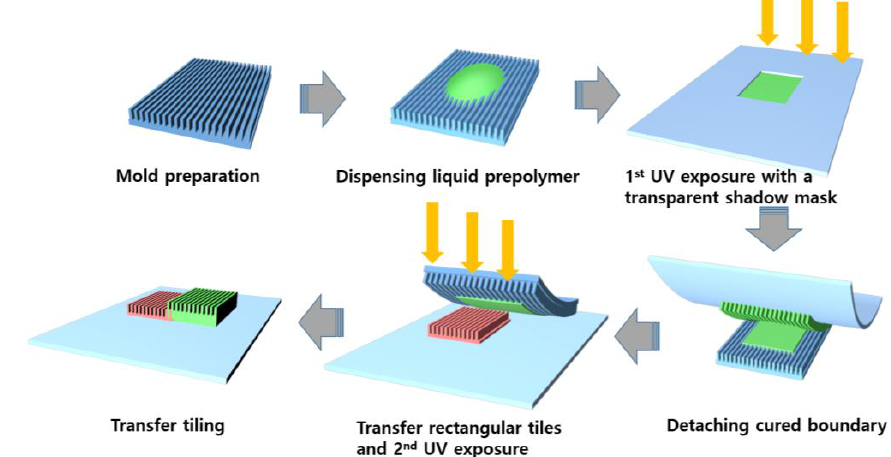
Figure 1. Schematic illustration of the experimental procedure.